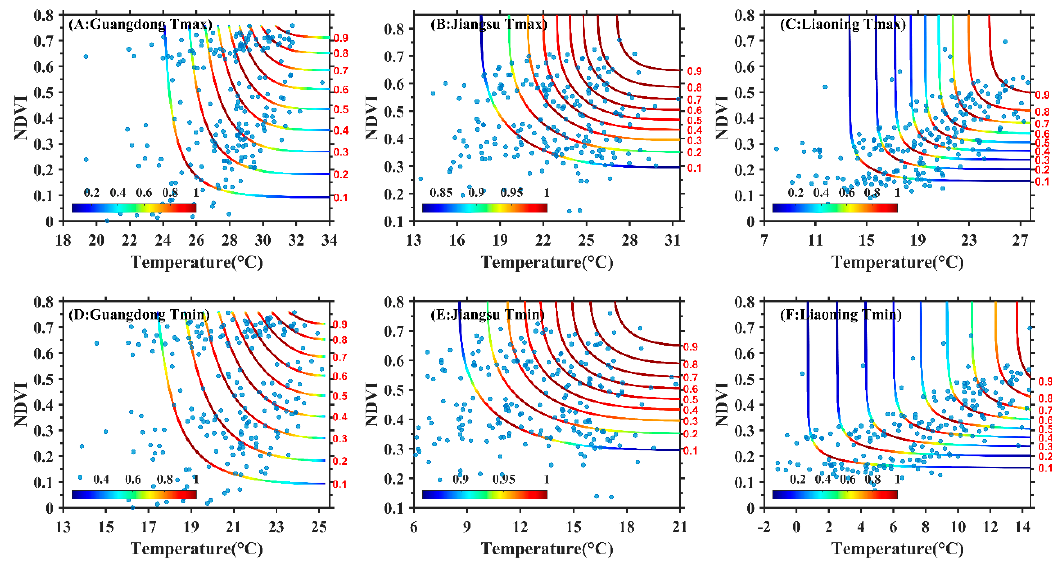
Figure 4. Copula joint probability distributions of Tmax–NDVI and Tmin–NDVI in spring in Guangdong, Jiangsu and Liaoning from 1982 to 2016.